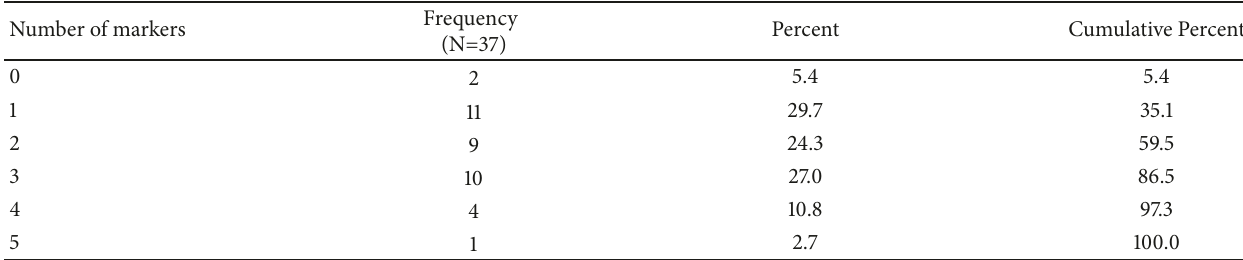
Table 5: Frequency of the number of sonographic markers